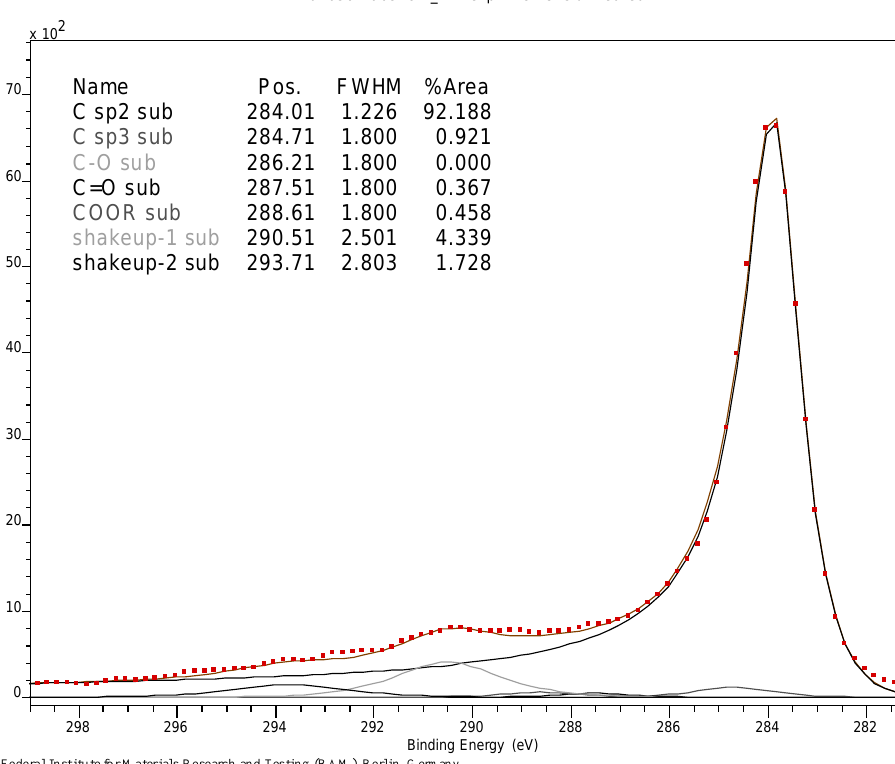
Figure 11. C-1s peak (XPS) of pristine MWCNT sample CNT0.